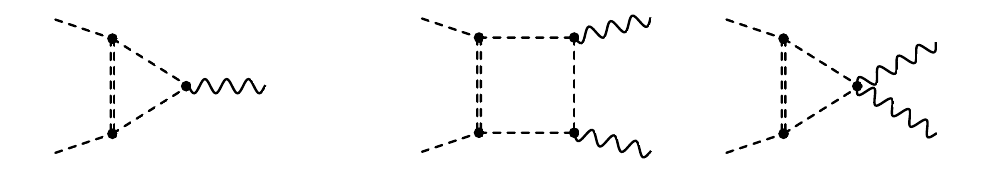
Figure 10 . Examples of one-loop heavy-light scalar diagrams that need to be considered to extract the one-loop matching corrections of the bosonic dimension-six SMEFT operators in (3.4) that do not receive a tree-level Wilson coe(cid:14)cient. The line styles and their meanings resemble those of (cid:12)gure